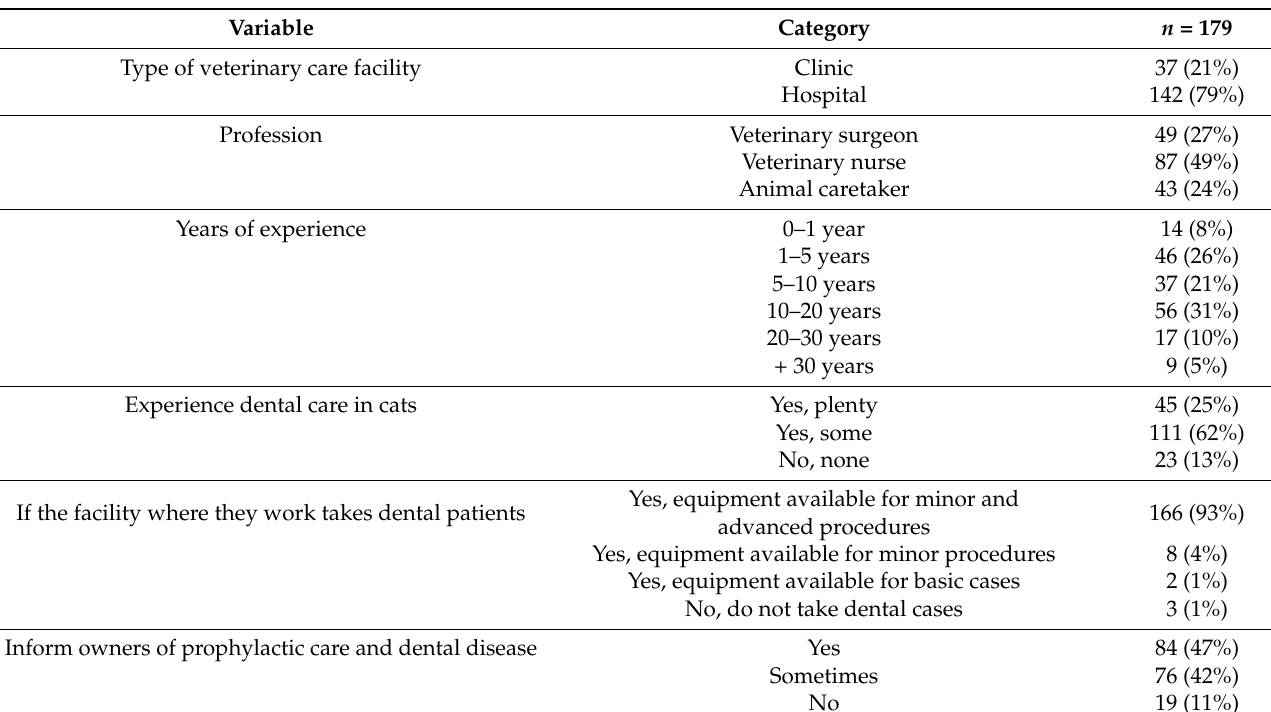
Table 5. Description of the respondents among veterinary care staff, n = 179, from a survey to veterinary clinics and hospitals on information from staff to cat owners regarding dental problems and